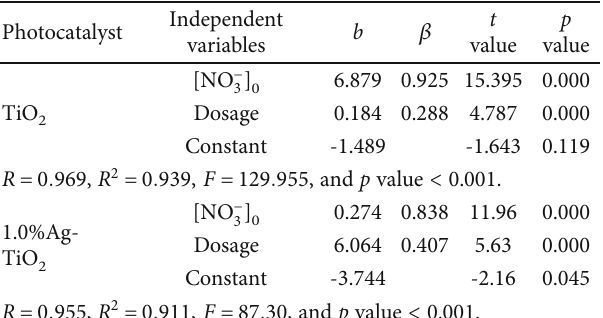
Figure 5: The catalytic selectivity of the photocatalytic reduction scheme under various [ NO − Table 3: Results of multiple linear regression analysis.